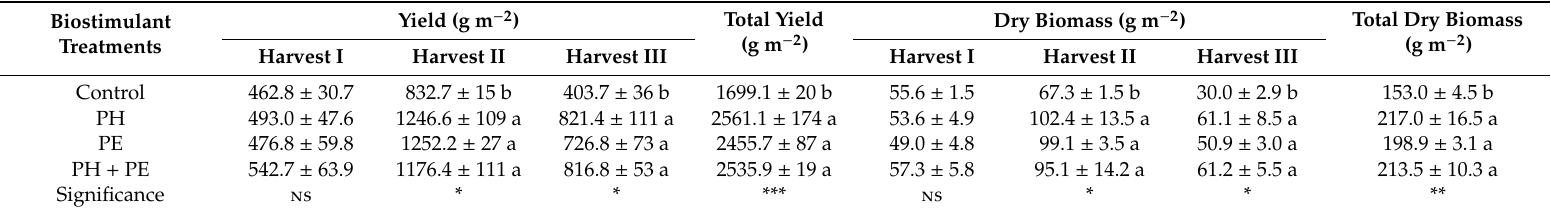
Table 1. E ff ect of foliar applications of protein hydrolysates (PH) and tropical plant extract (PE) alone or in combination on marketable yield and dry biomass of grenhouse cultivated perennial wall rocket.